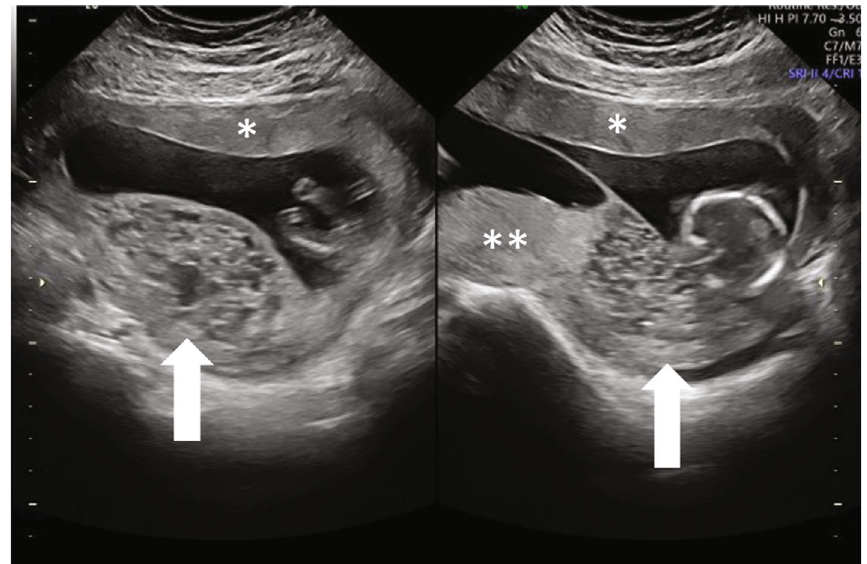
Figure 1: Ultrasound at 21 weeks showing three separate placentas and a dividing membrane ∗ Twin A placenta. ∗∗ Twin B placenta. Up arrow: molar placenta.